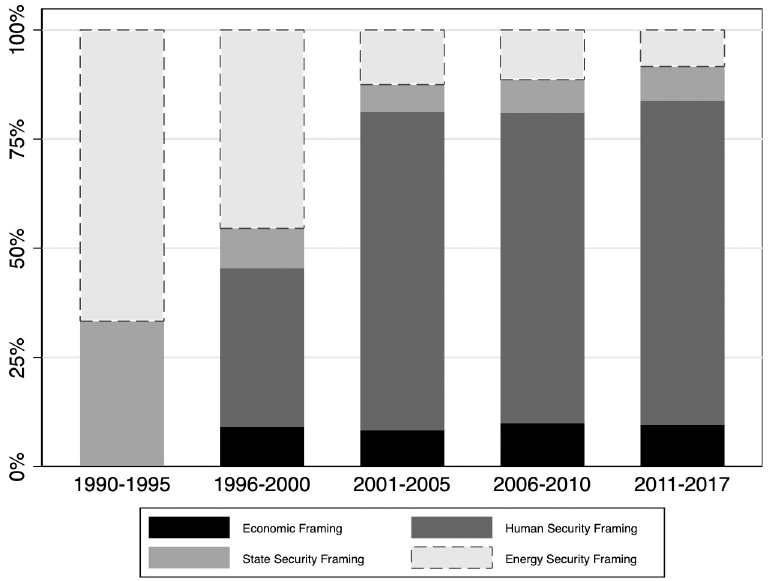
Fig 3. Proportion of the instances of adaptation framings in four categories to the total number of framings in a five-year period, 30 IOs, 1990–2017.